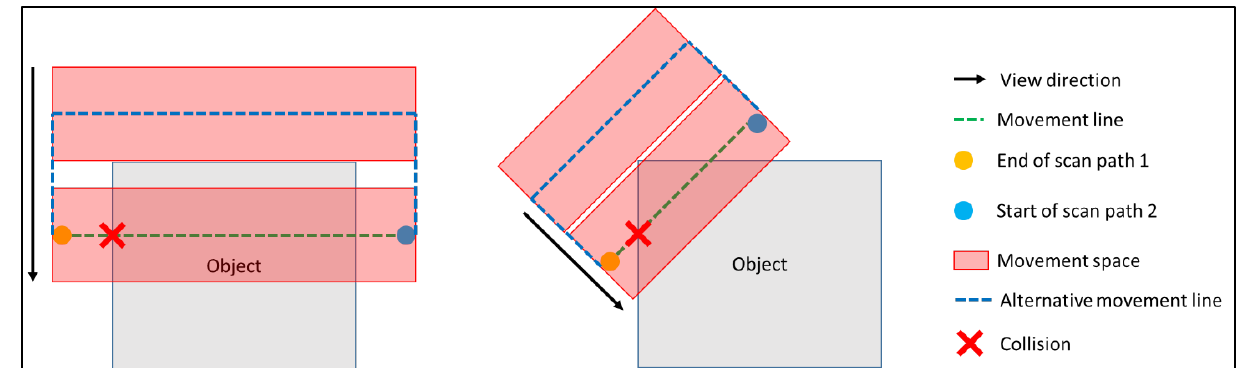
Figure 9. Adaption of the movement line in case of a collision.